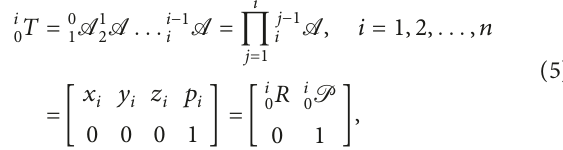
Figure 3: Manipulator model with flexible joints, load, and magnetorheological breaks coupled to the joints.